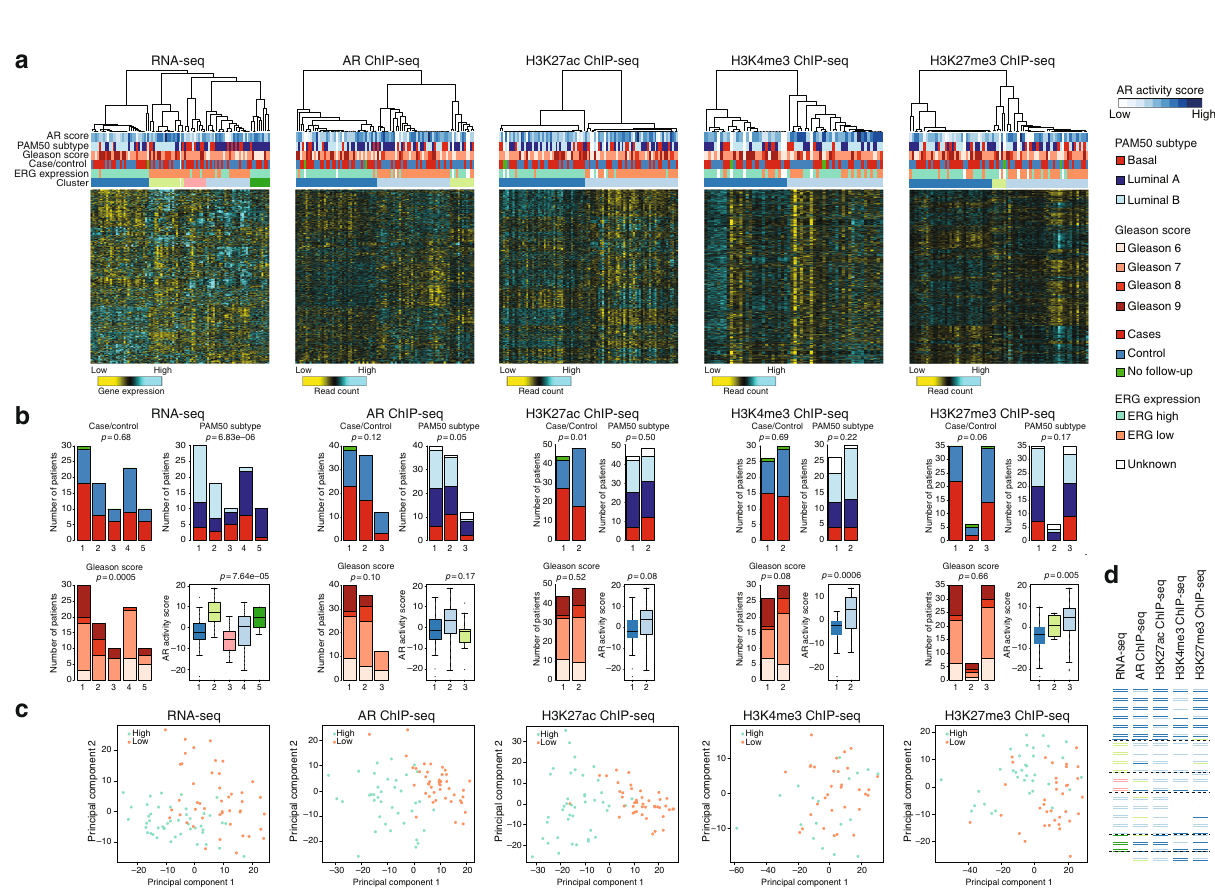
Fig. 3 Consensus clustering of prostate cancer samples by each dataset. a Heatmaps of RNA expression, AR binding, H3K27ac, H3K4me3, and H3K27me3 ChIP-seq signal. Each sample is annotated for AR activity score, PAM50 subtype, Gleason score, case/control status, ERG expression, and consensus cluster assignment. Samples are ordered according to consensus clustering in Supplementary Figure 6. As shown in the color scale for RNA-seq, yellow indicates relatively low expression and blue relatively high expression ( z -scores), whereas for ChIP-seq, yellow indicates relatively low peak intensity and blue relatively high peak intensity ( z -scores). b Plots showing the distribution of case/control status, Gleason score, PAM50 subtypes, and AR activity score across the clusters identi fi ed in RNA-seq, AR ChIP-seq, H3K27ac ChIP-seq, H3K4me3 ChIP-seq, and H3K27me3 ChIP-seq datasets. Boxplots represent median AR activity scores with interquartile ranges. c PCA scores plot for RNA expression, AR binding, H3K27ac, H3K4me3, and H3K27me3 ChIP-seq signal, based on the top 1000 most-varying genes/regions across the samples. Samples are colored according to ERG high or low expression. d Comparison of consensus cluster assignment of the samples (rows) for each datatype